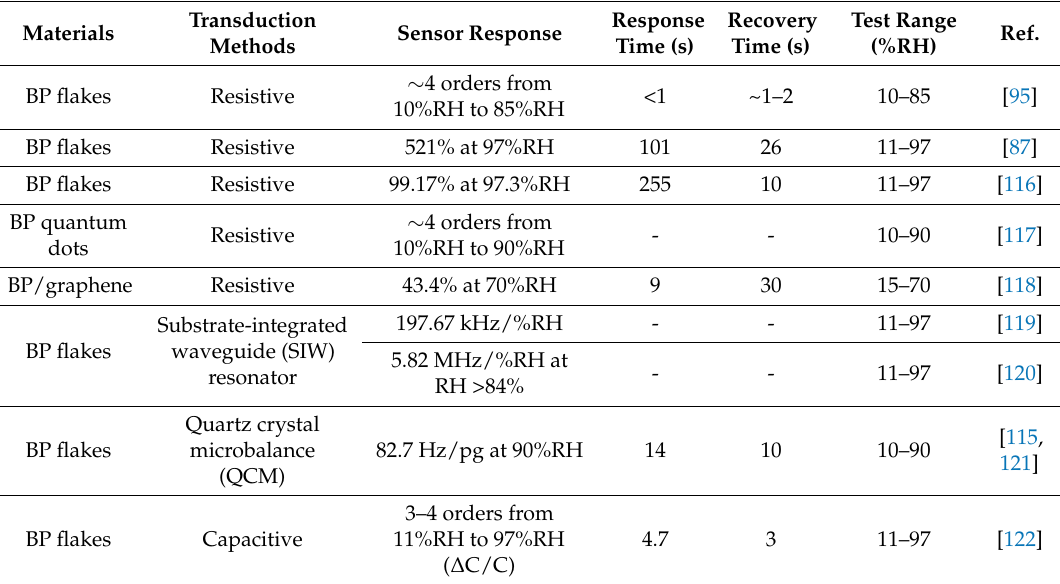
Table 3. The list of the performances of different humidity sensors based on black phosphorus (BP).